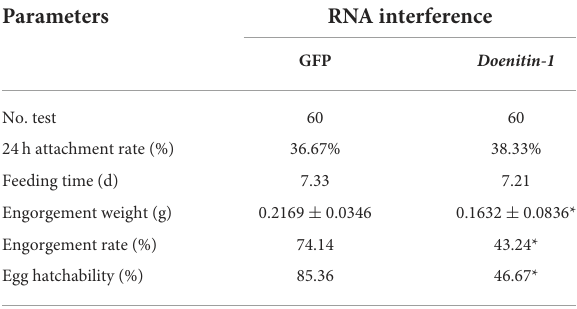
TABLE 4 Effects of the RNAi of Doenitin-1 on biological traits of H. doenitzi